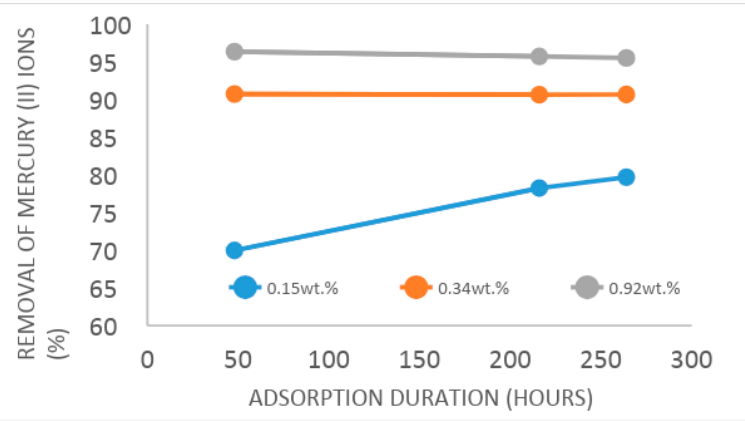
Figure 4. A comparative Hg 2+ adsorption capacity of